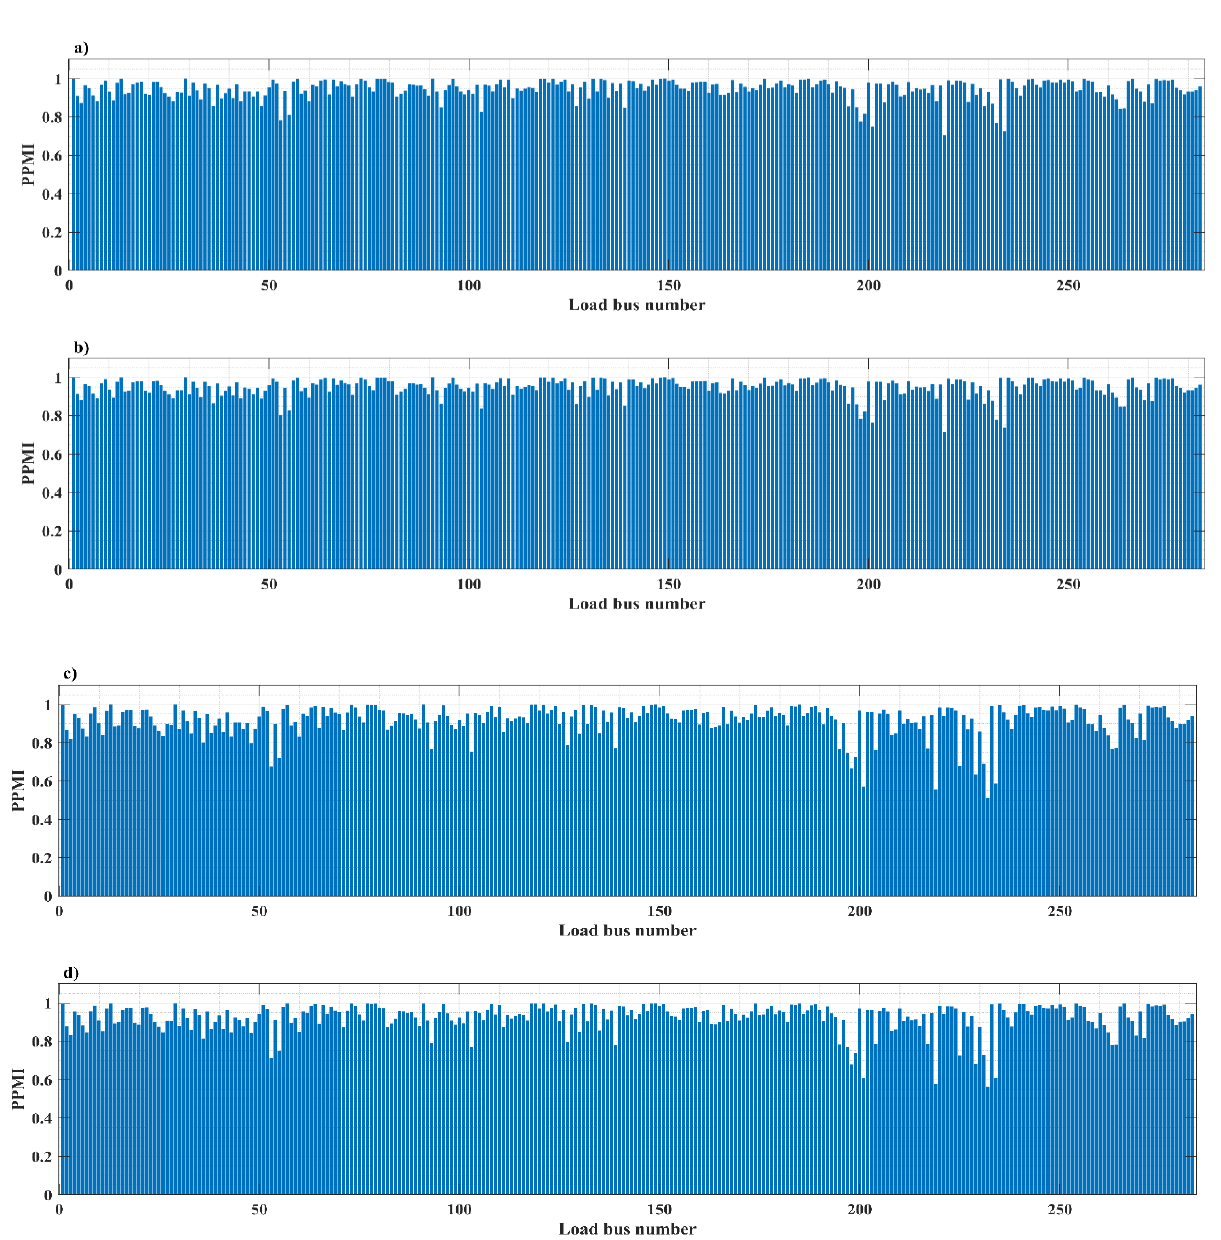
Figure 8. Active power margin index under different loading condition; a) Light load uncompensated system b) Light load compensated system c) Heavy load uncompensated system d) Heavy load compensated